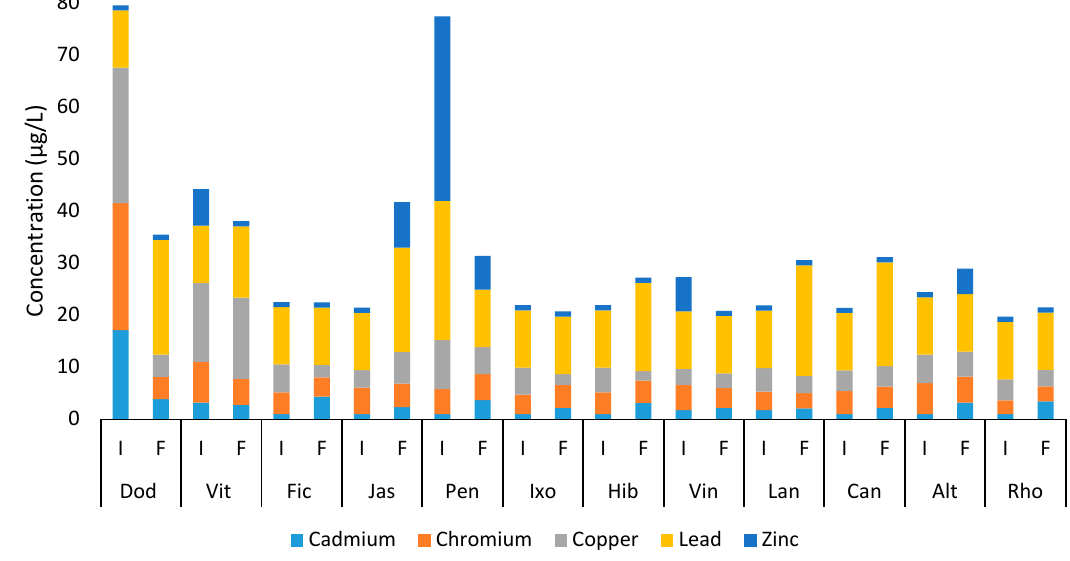
Figure 1. Average concentration of heavy metals in effluent water samples at the beginning (l, before irrigation with synthetic greywater) and at the end (F, after irrigation with synthetic greywater) of the experiment (please see Table S1 for the data).